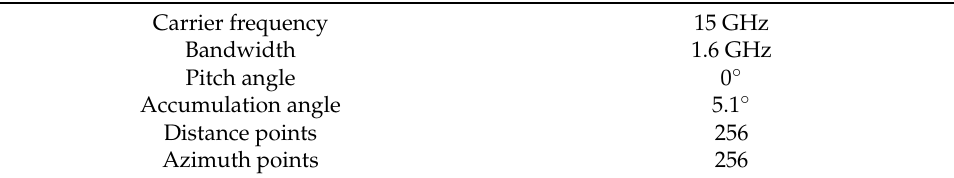
Figure 8. Three-dimensional model of Tiangong. Table 3. Radar simulation parameters.